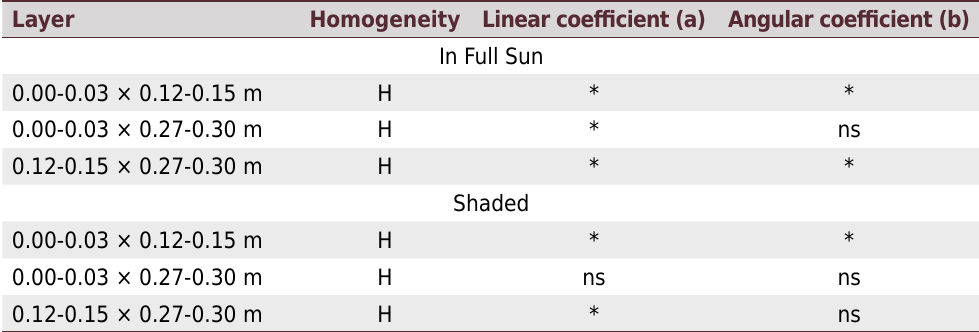
Table 2. Statistical comparison of load-bearing capacity in soil depth occupied by coffee plantations under full sun and shade management regimes